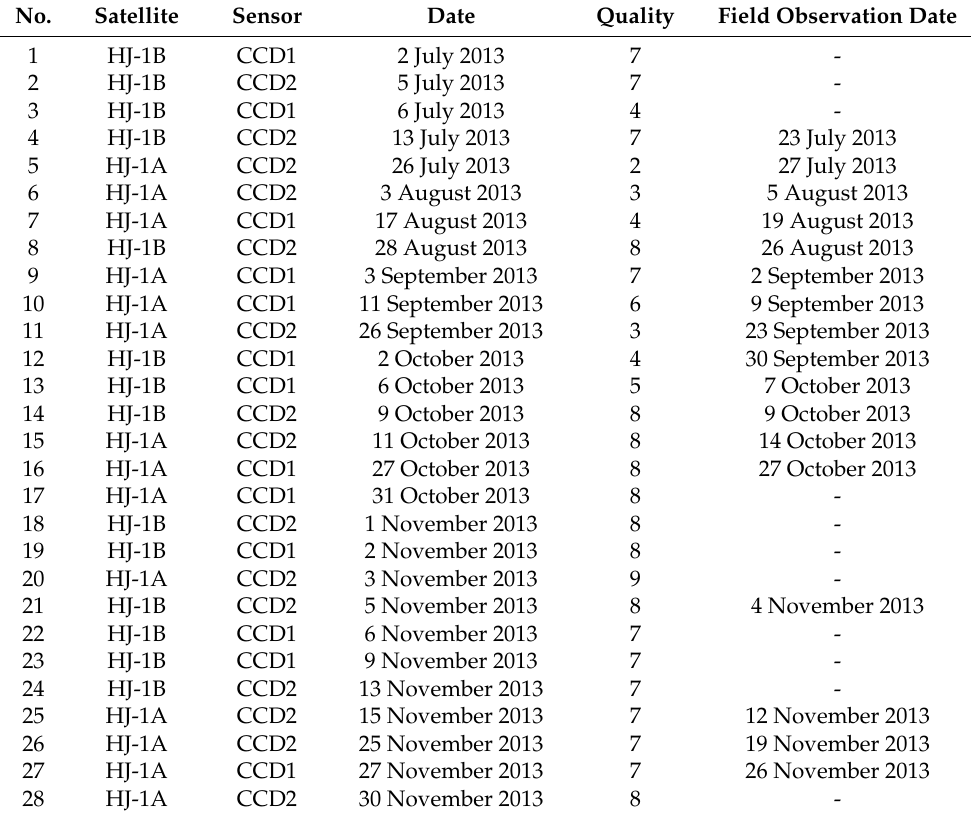
Table 4. Dates of the selected HJ-1A/B imagery and field observations.